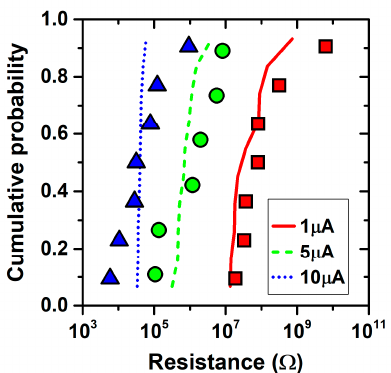
Figure 5. Experimental (symbols) and simulated (lines) cumulative distributions of TiN/5 nm HfO x /TiO y /TiN RRAM stacks’ low state resistances after forming at 1, 5, and 10 µA. The forming process was performed using a ramped voltage and 25 °C external temperature.